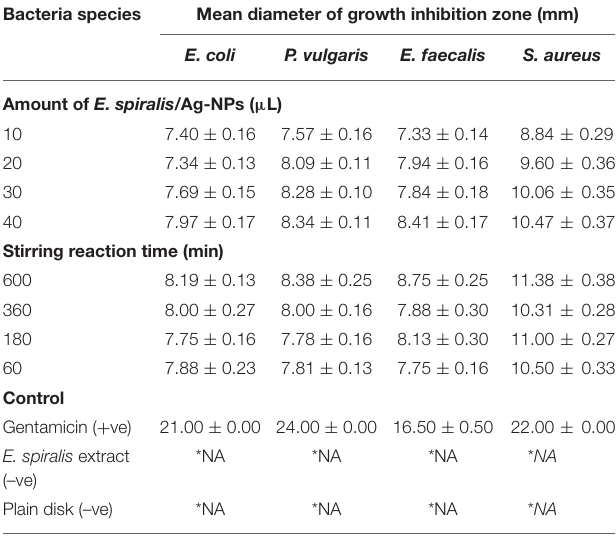
TABLE 2 | The diameter of the growth inhibition zone at different parameters against different types of bacteria species. Bacteria